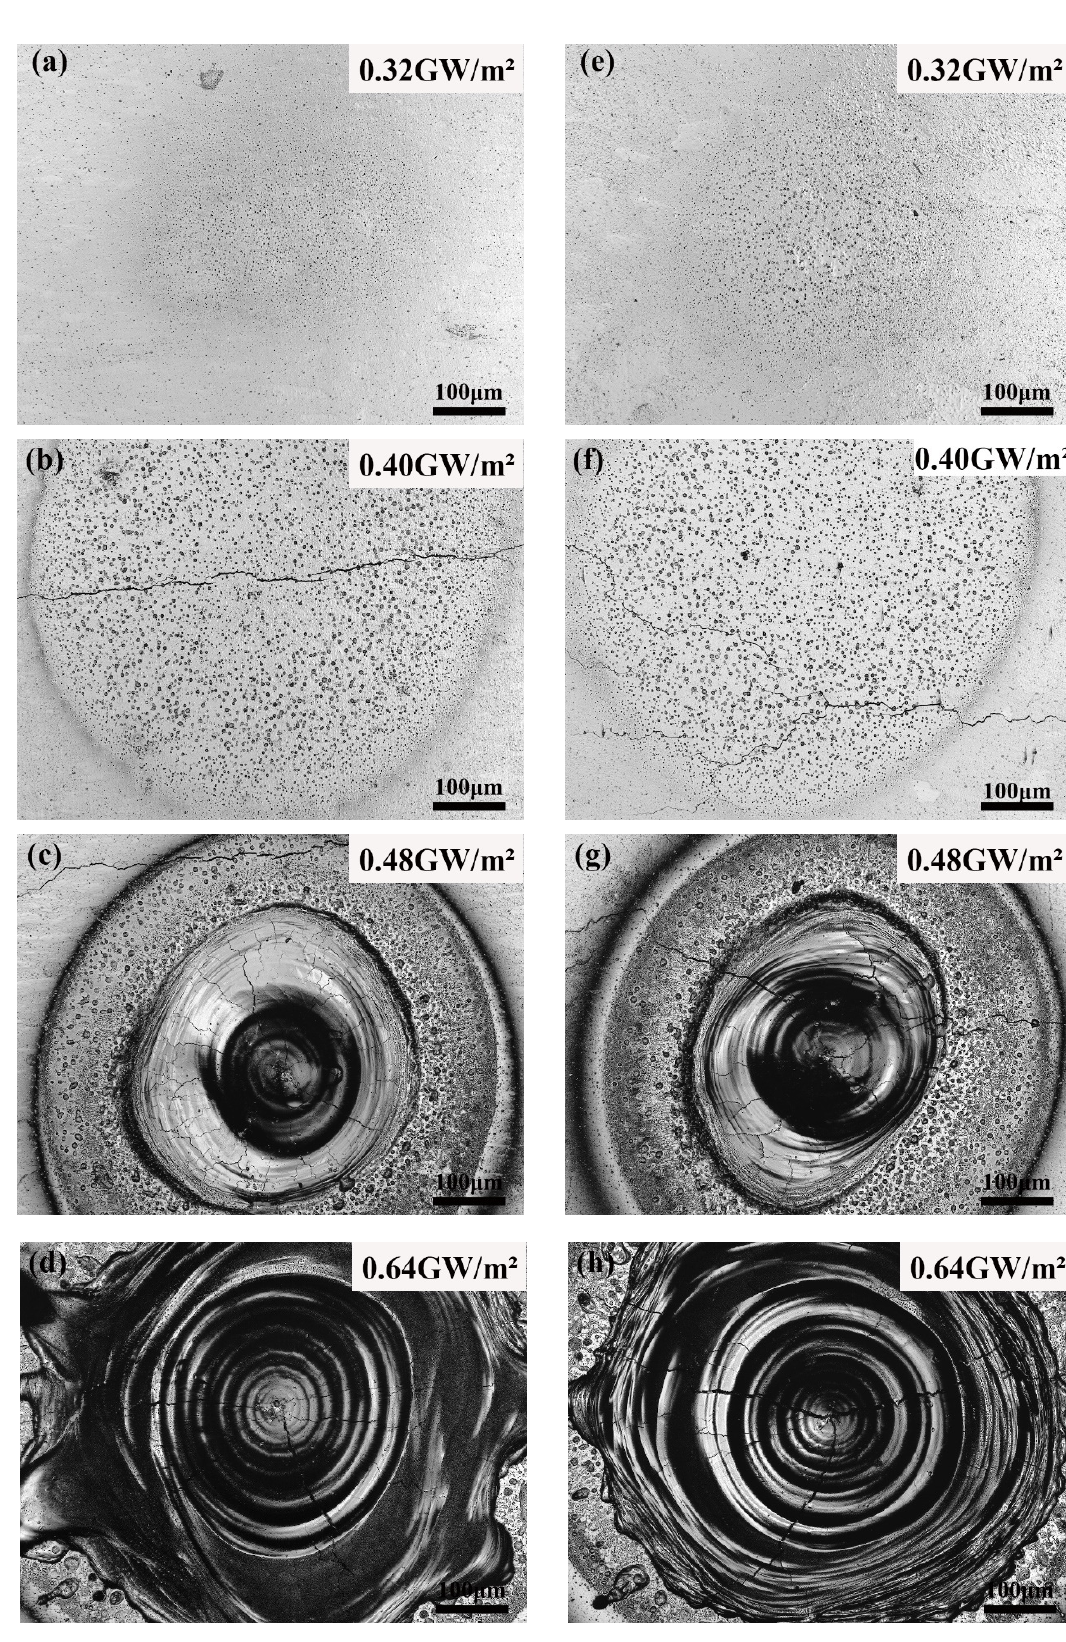
Figure 6. The local surface morphologies corresponding to the Figure 5 ( a–h ): rolled samples ( a – d ); fully recrystallized samples ( e – h ).